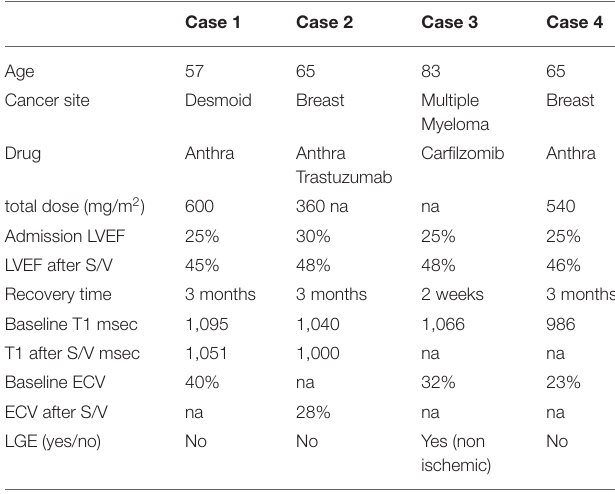
TABLE 1 | Summary of clinical and imaging characteristics of the presented